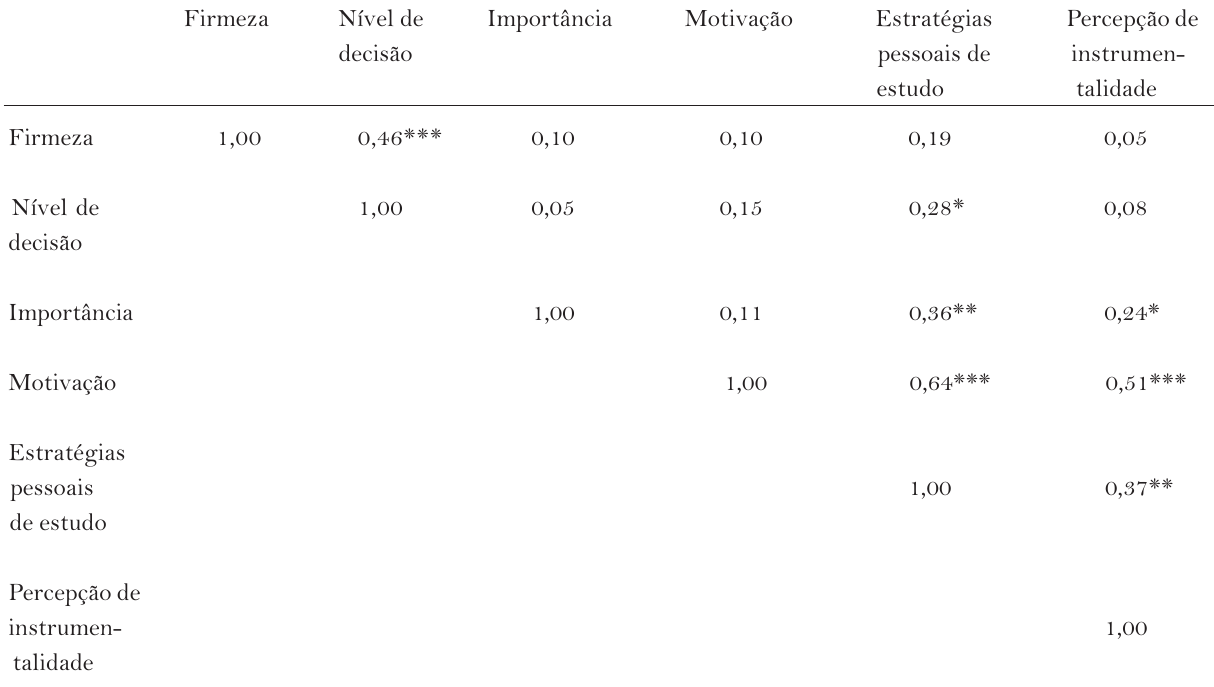
Tabela 1 Correlações de Pearson entre as Variáveis de Definição Vocacional, Grau de Motivação, Uso de Estratégias Pessoais de Estudo e a Percepção de Instrumentalidade dos Estudos Atuais